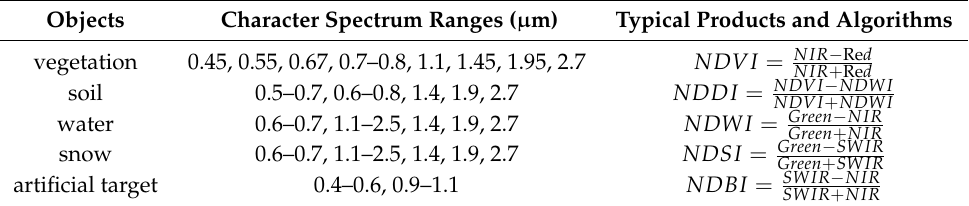
Table 1. Typical objects and corresponding